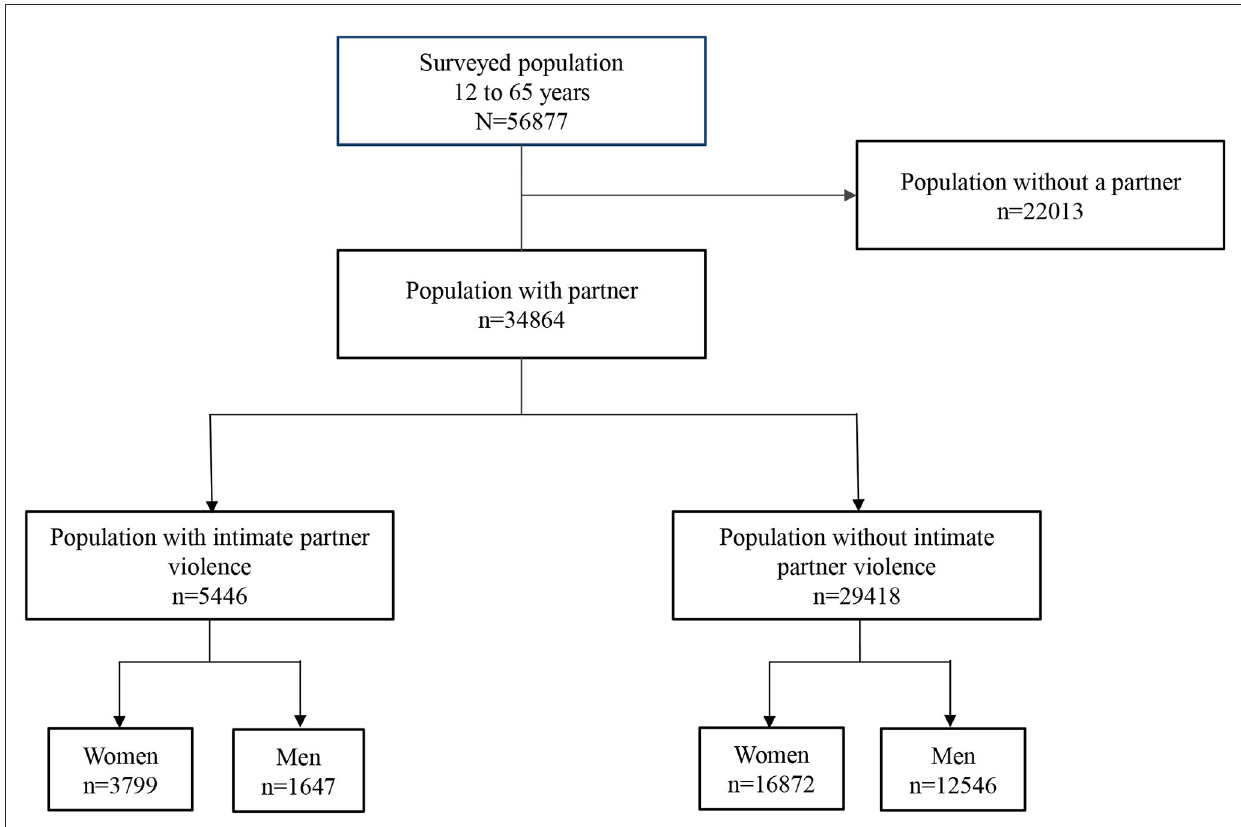
FIGURE1 Study population of psychological distress and intimate partner violence. Encuesta Nacional de Consumo de Drogas, Tabaco y